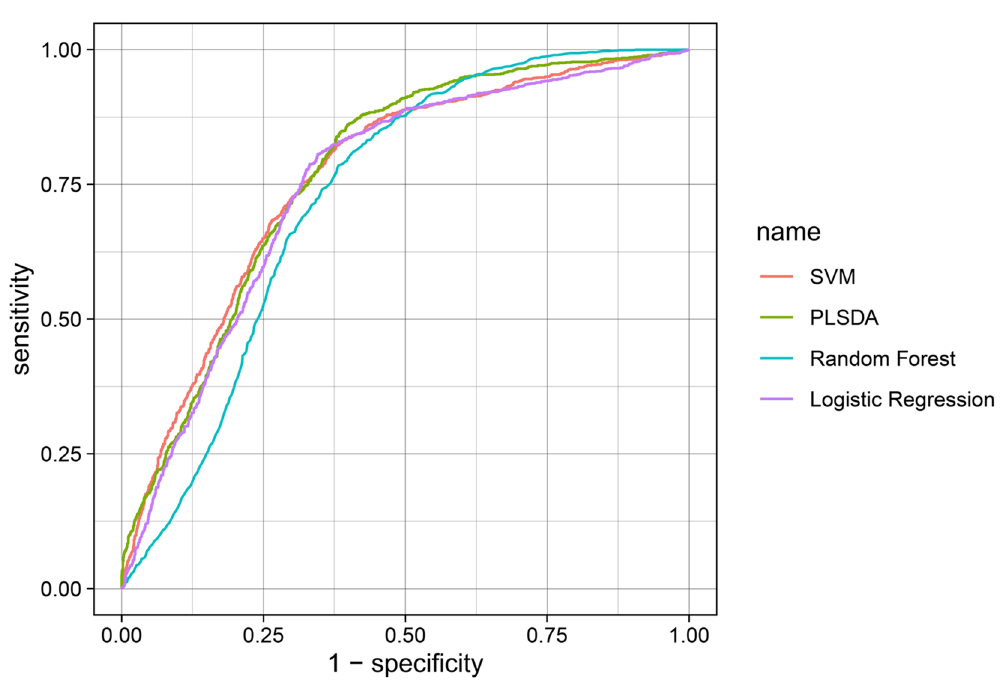
Figure 3. Receiver operating characteristics (ROC) curves for supportive vector machine (SVM), PLS-DA, random forest, and logistic regression